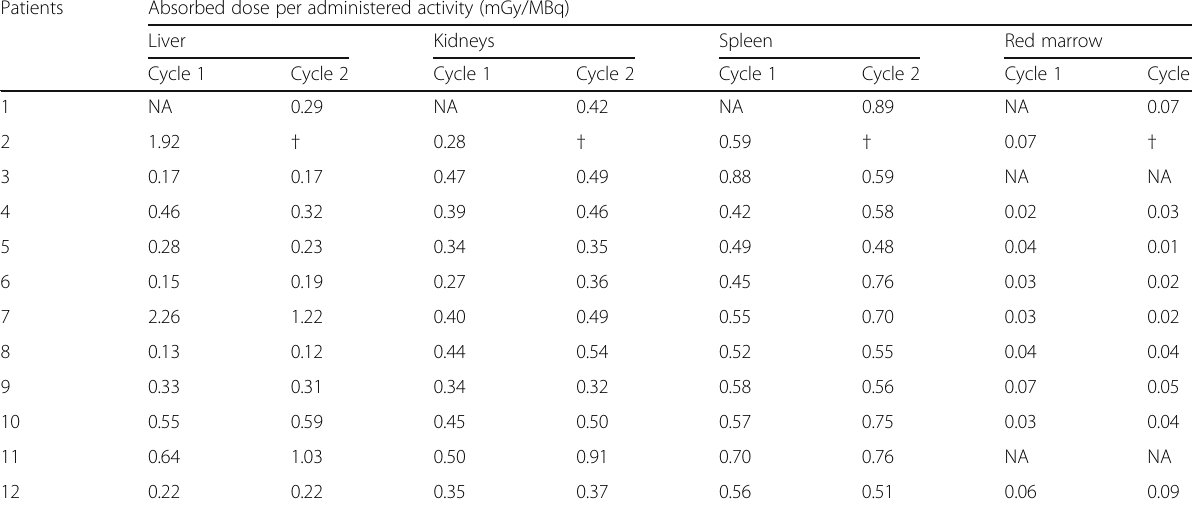
Table 3 Absorbed dose per administered activity (AD/A admin; in mGy/MBq) to the liver, kidneys, spleen, and red marrow after cycle 1 and cycle 2. The AD/A admin presented in the table were calculated with personalized organ masses Patients Absorbed dose per administered activity (mGy/MBq) Liver Kidneys Spleen Red marrow Cycle